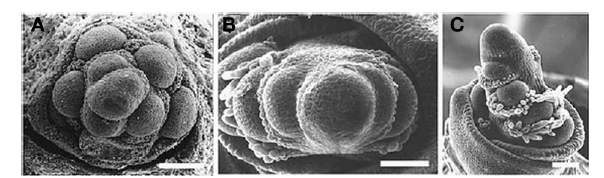
FIGURE 12 | Early development of the inflorescence of Oryza sativa . (A) wild type. (B,C) , apo1 mutant. Reproduced with permission from Ikeda et al.